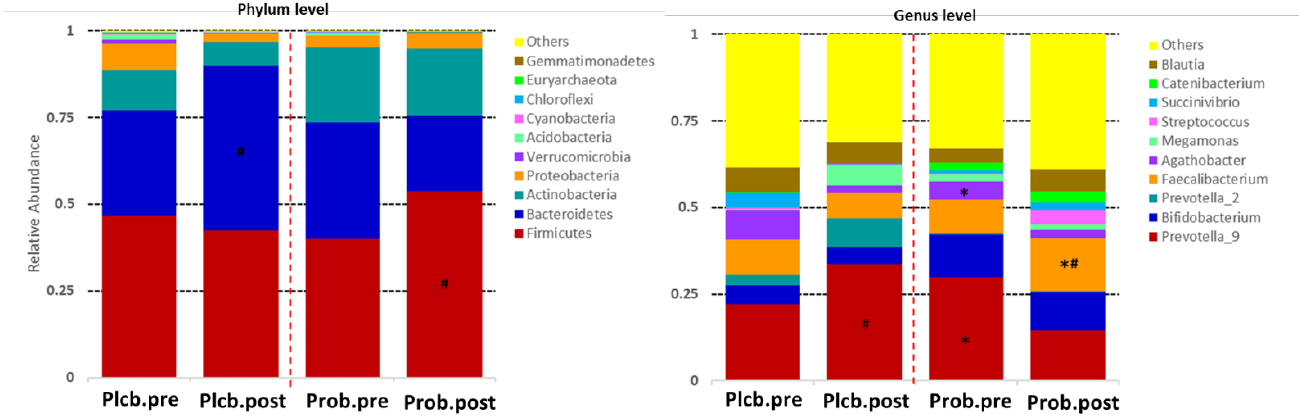
Figure 3. Top 10 relative abundance of gut microbiota composition between groups. ǂ PlcbPre – ProbPre; # PlcbPost – ProbPost; * ProbPre – ProbPost.